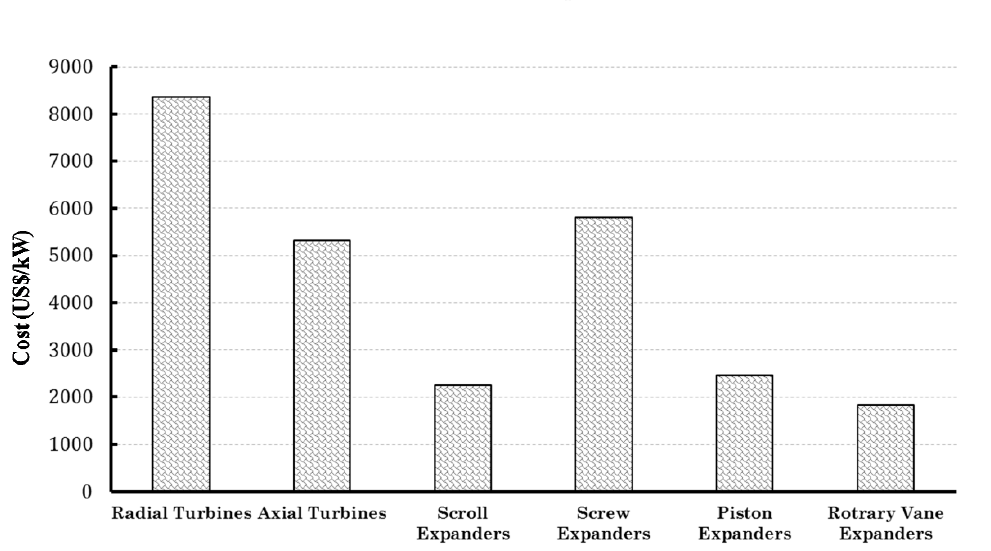
Figure 14. Cost estimation of expanders according to their power output only.